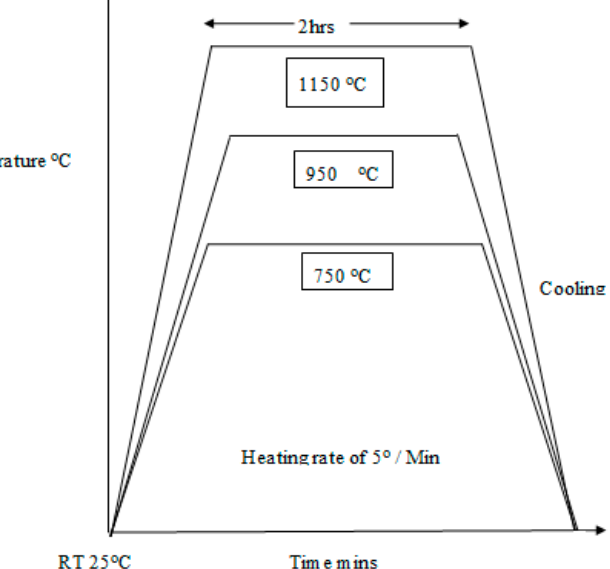
Figure 2. Schematic diagram for the growth process of the In x Ga 1-x N alloy under different temperatures.